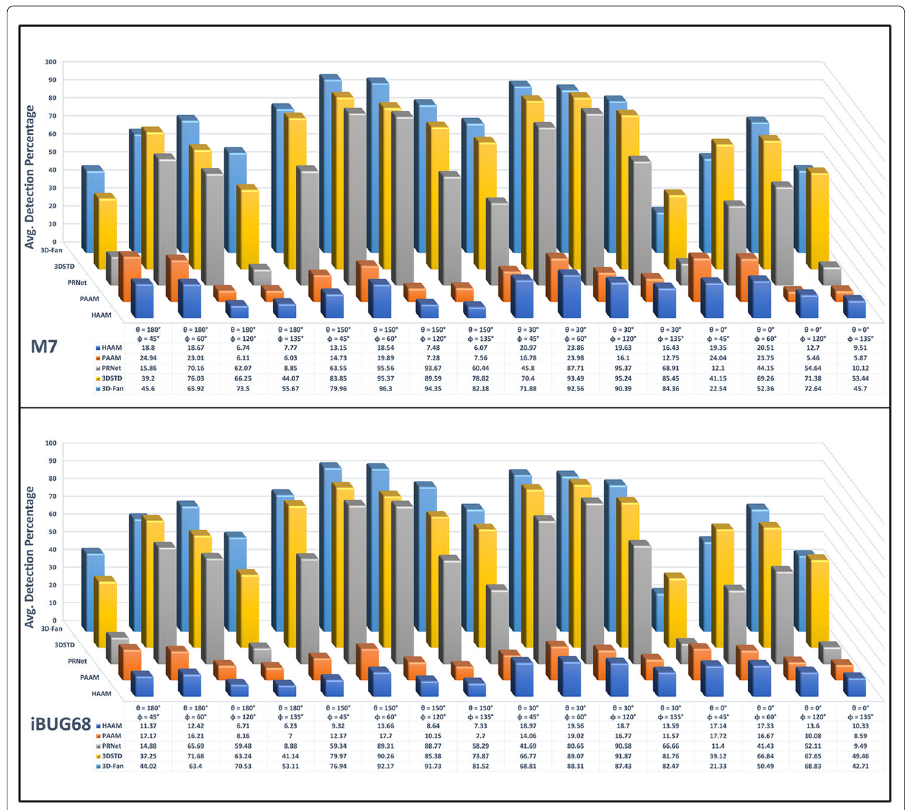
Fig. 17 Camera position with group of outer view. The outer view position where φ = 45 ◦ , 60 ◦ , 120 ◦ , and 135 ◦ ; θ = 0 ◦ , 30 ◦ , 150 ◦ , and 180 ◦